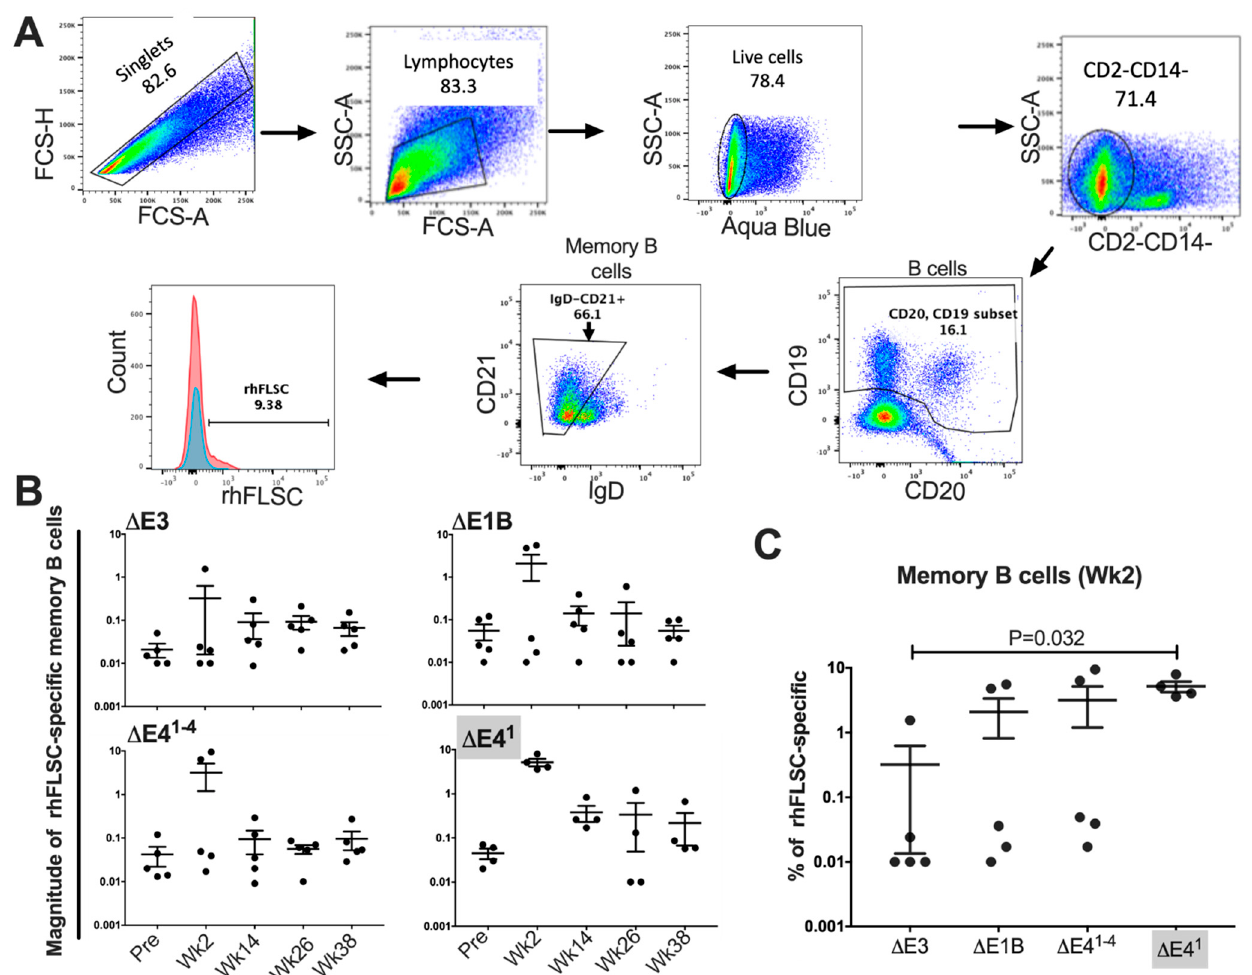
Figure 5. Mucosal rhFLSC-specific memory B-cell gating strategy and frequency in Ad vector- immunized rhesus macaques. ( A ) Representative gating of memory B-cells. ( B ) Percentages of rhFLSC-specific memory B-cells over the course of immunization were calculated based on total B-cells at each time point. p values were obtained using the Wilcoxon signed-rank test. ( C ) Percentage of rhFLSC–specific memory B-cells for each vector at Week 2 post-initial immunization. p values were obtained using the Mann–Whitney two-tailed test.